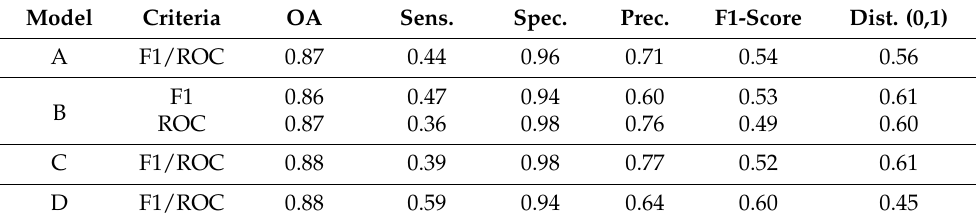
Table 7. Results of the Random Forest (RF) with the best parametric configuration for each variable combination. Criteria for the selection of the best mode are maximum F1-score (F1), minimum distance to the optimal point (0,1) in the ROC curve (ROC) or both (F1/ROC). All the metrics are computed from the validation set. (OA: Overall accuracy; Sens.: sensitivity; Spec.: specificity; Prec.: precision; Dist. (0,1): distance to the point (0,1) in ROC curve). Model